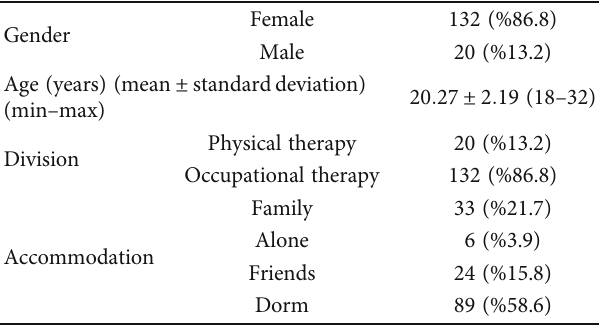
Table 1: Sociodemographic properties of the